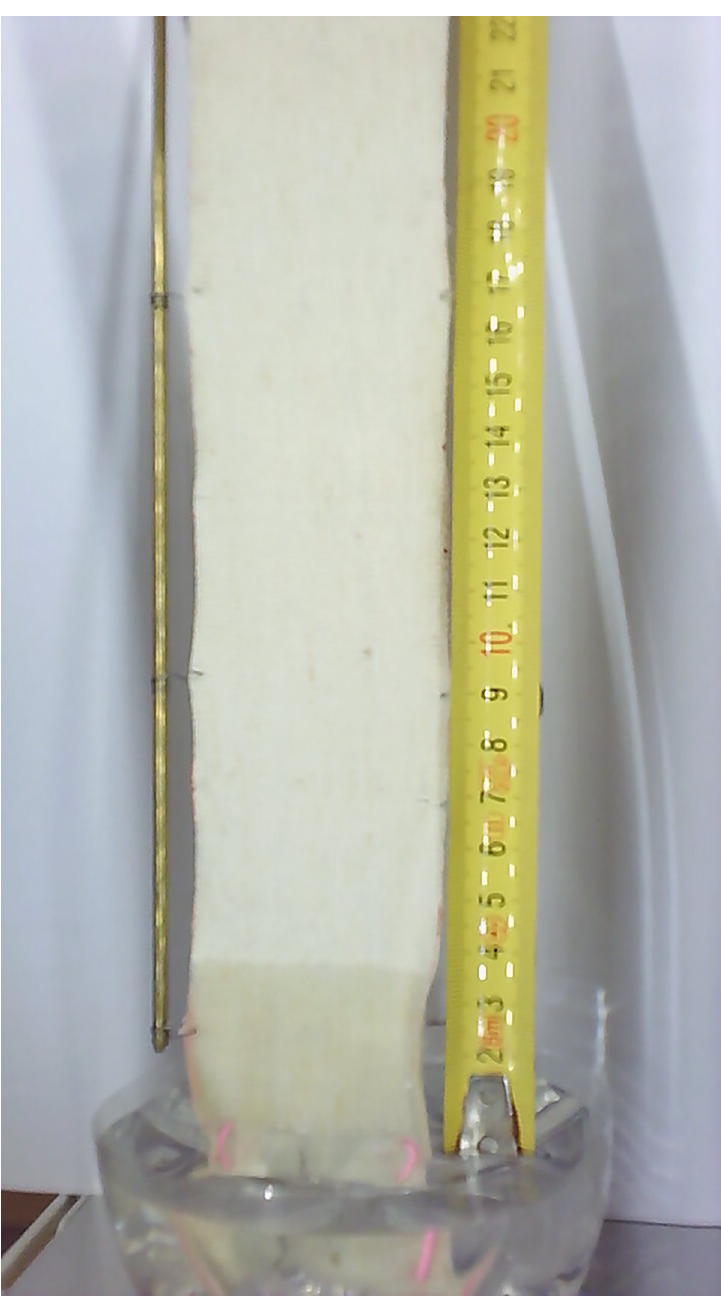
Fig 2. Example of the recorded image during determination of wicking of the hemp knitted fabric.